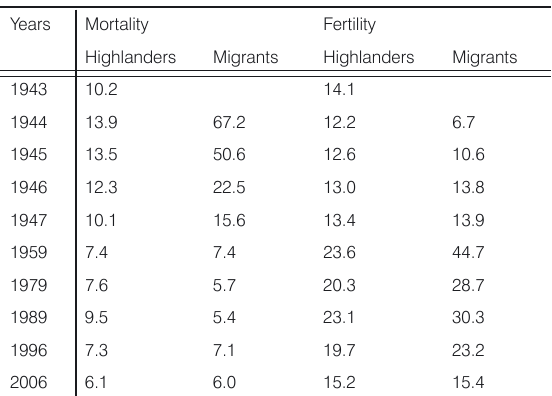
Figure 2. Morbidity rates per 10,000 in 1944-1945 among Lowlanders (_ _ _ ) and Migrants( ___ ) for Malaria (A) and Typhus (B).